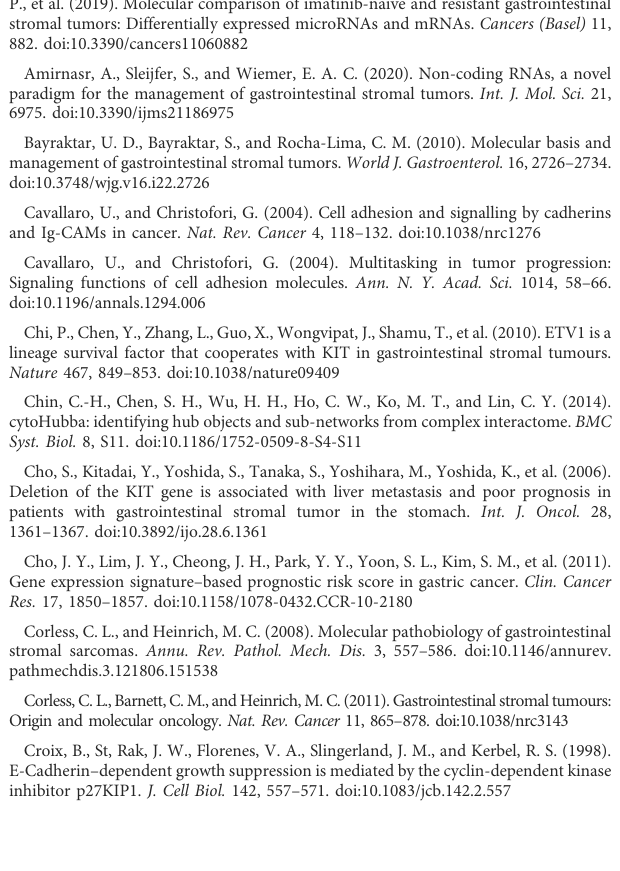
(A) Volcanomapofdifferentiallyexpressedgenes(Upregulatedgenesinred, downregulated genesinblue). (B) Hierarchicalclustering heatmap ofDEGs screened on the basis of FC > 2.0 and a corrected P value < 0.05. (C) Shows PCA results of our cohort. (D) Visual hierarchical cluster analysis. SUPPLEMENTARY FIGURE S2 Expression of ETV1 and ETV4. (A, B) Expression of ETV1 and ETV4 in GIST (with liver metastasis) tissues and correspond non-tumor tissues in our cohort. (C, D) . Expression of ETV1 and ETV4 in primary GIST tissues and correspond non-tumor tissues in GSE13861